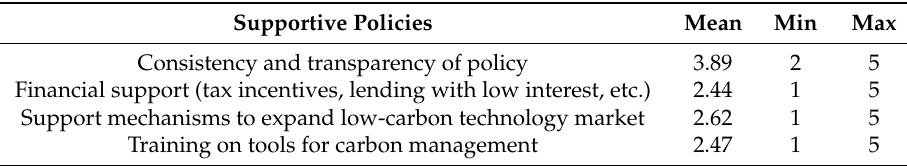
Table 11. Supportive policy and measures for implementing CMAs ( n =